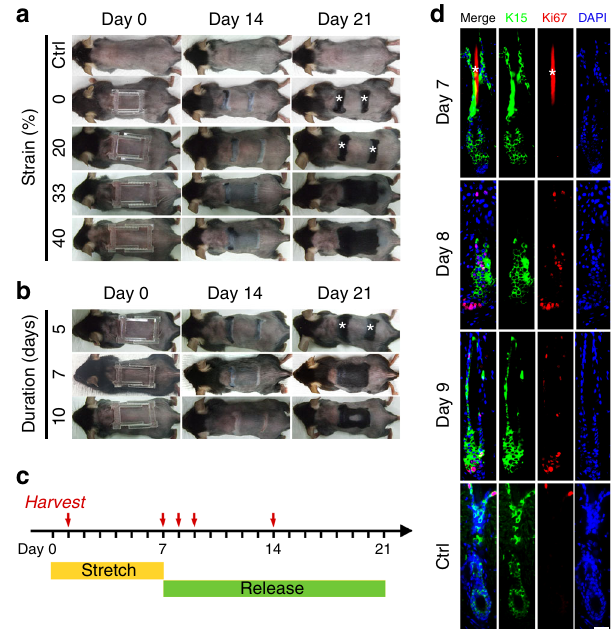
Fig. 1 Stretch-induced hair regeneration is dependent on strain and duration. a Stretch for 7 days under different amounts of strain. Note hair regeneration occurred in response to 33 or 40% strain, but not in the control (without the device) or under 0 or 20% strain; n = 6 for each group. Day 0 represents the day on which strain was applied. *Anagen initiated in glue- fi xed area due to hair plucking when removing the skin-stretching device. b Stretch under 33% strain for different durations. Note hair regeneration occurred in the 7-day (total) and 10-day (only in peripheral area) duration groups, but not in the 5-day duration group; n = 6 for each group. c Schematic of the optimal stretching conditions and sample collection times. d Dual immunostaining for K15 and Ki67 revealed that K15 + hair stem cells began to proliferate on days 8 and 9 when stretch was released. Scale bar = 50 μ m. *Auto fl uorescence of hair